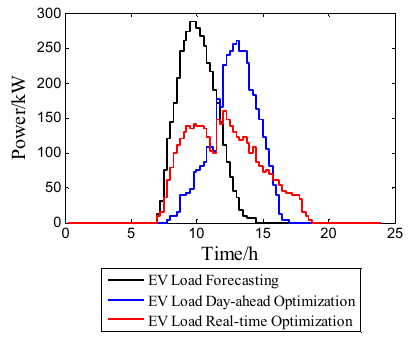
Figure 10. EVs’ load profiles of forecasting, day-ahead and real-time